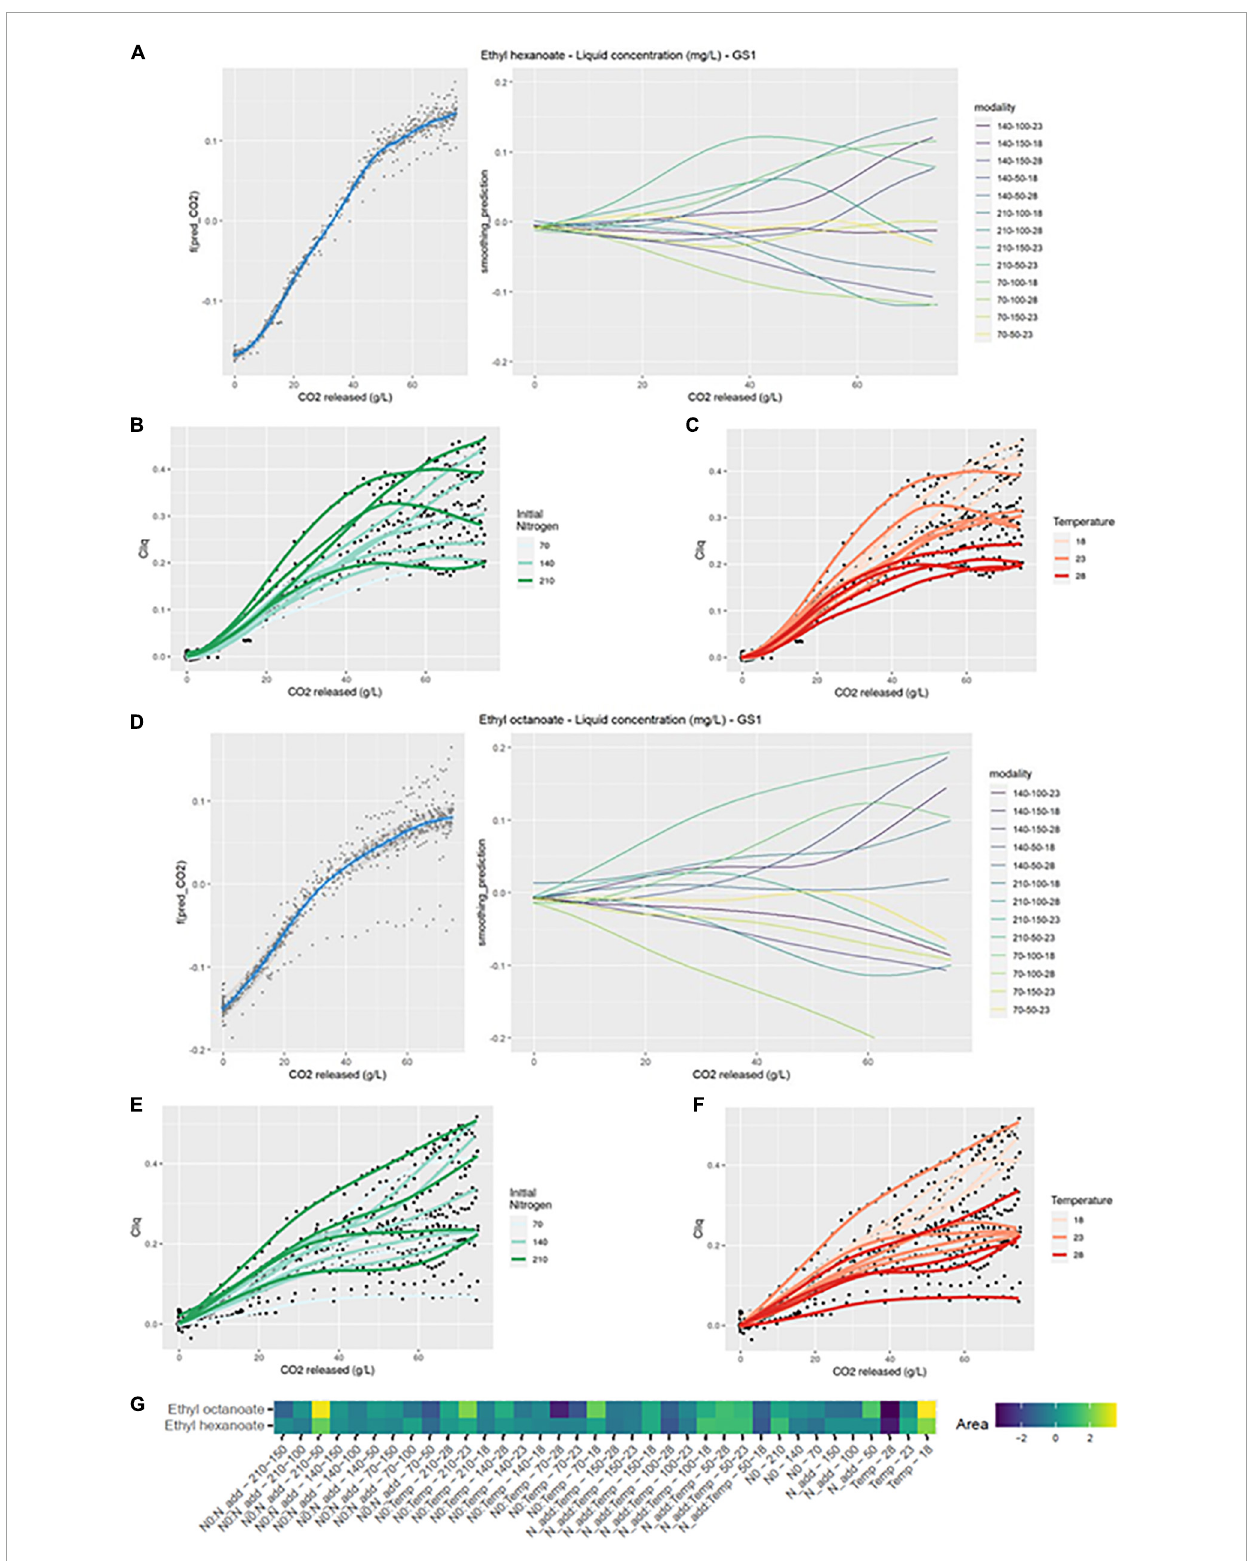
FIGURE4 GAM modeling of EHE and EOC production kinetics. (A,D) Left: Smoothing average of EHE and EOC concentration, right: Deviations of each modality from this average smoothing. (B,C,E,F) Prediction curves for each modality represented with a color depending on the level of NO and temperature. (G) Heatmap representing magnitudes of each factor and every possible interaction using areas under the curves of the deviations from the average smoothing, for EHE and